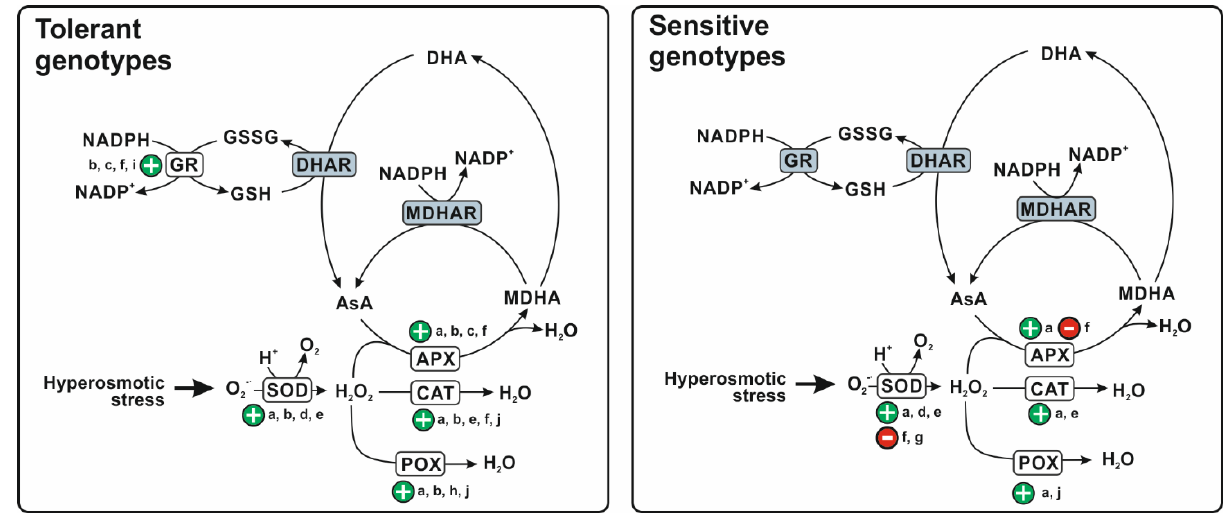
Figure 1. Changes in the antioxidant defence system in shoots/leaves of tolerant and sensitive durum wheat genotypes. SOD, superoxide dismutase; APX, ascorbate peroxidase; CAT, catalase; POX, peroxidases, MDHAR, monodehydroascorbate reductase; DHAR, dehydroascorbate reductase; GR, glutathione reductase; AsA, reduced ascorbate; MDHA, monodehydroascorbate; DHA, dehydroascorbate, GSH, reduced glutathione; GSSG, oxidized glutathione. + and – signs refer to upregulation and downregulation of the enzymes, respectively. For the enzymes highlighted in gray, no sufficient data are available. The stoichiometry of the reactions is not always respected. (a) Feki et al. [52]; (b) Woodrow et al. [57]; (c) Sheng et al. [58]; (d) Ami et al. [59]; (e) Ayadi et al. [44]; (f) Huseynova [46]; (g) Huseynova et al. [47]; (h) Capriotti et